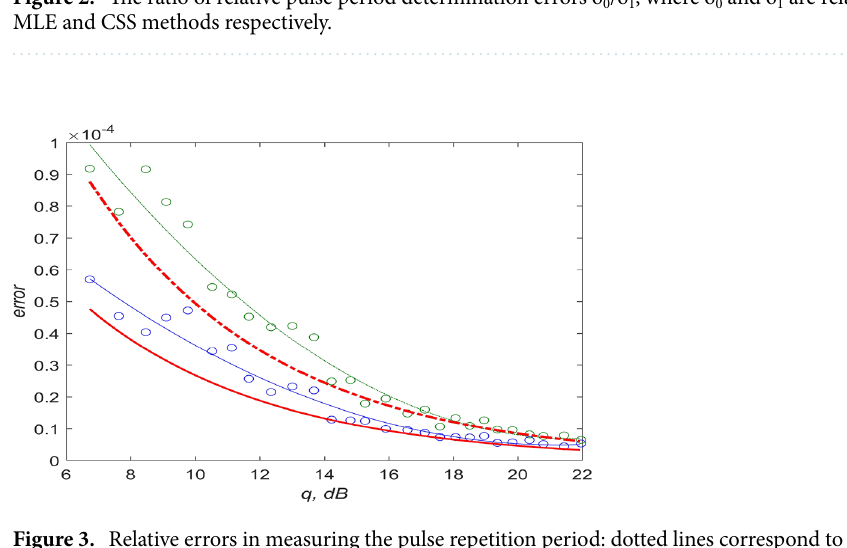
Figure 3. Relative errors in measuring the pulse repetition period: dotted lines correspond to the MLE, solid lines correspond to the CSS method, bold lines are errors calculated by formulas (11) and (42), thin lines are results of least squares method approximations of numerical modeling (circles—results of numerical modeling). The signal-to-noise ratio (SNR) is plotted along the X